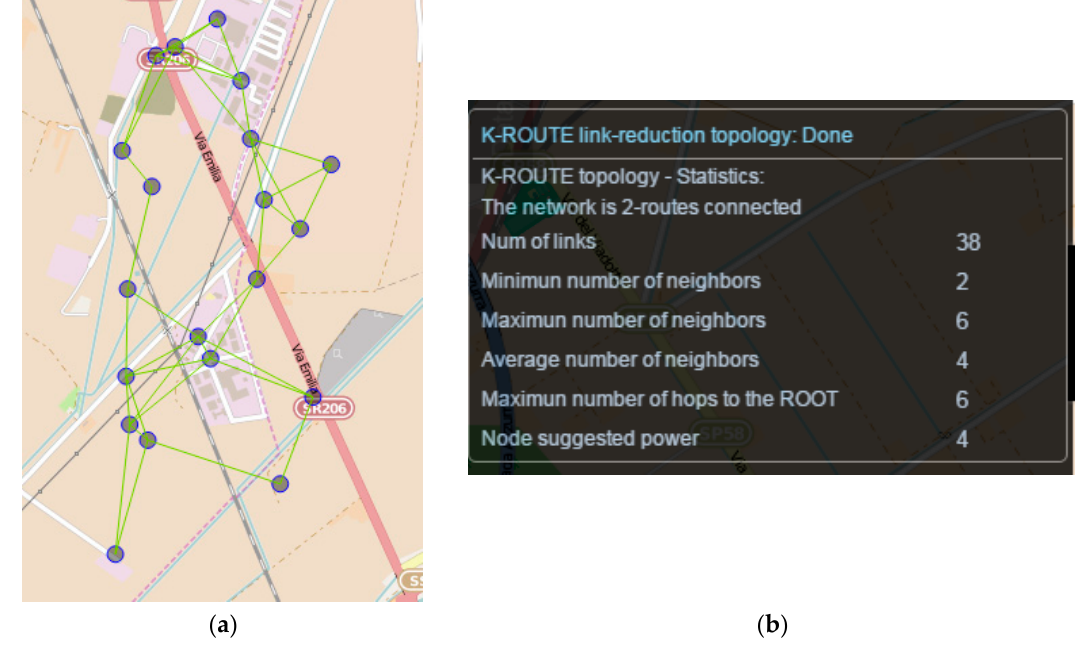
Figure 8. WSN-DPCM K-Route Link Reduction Integrated Algorithm (power in dBm): graphical results ( a ) and statistics ( b ).